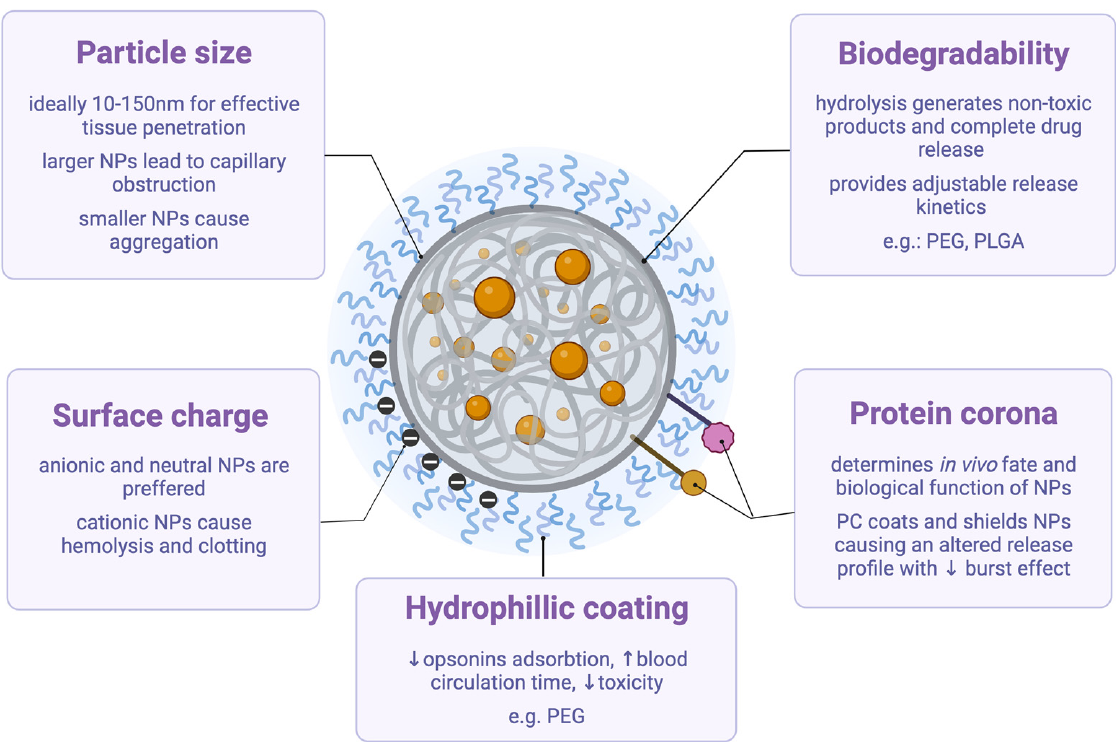
Figure 4. Factors affecting biocompatibility. This figure presents the main factors affecting the biocompatibility of nanoparticles (NPs), including their size, surface charge, hydrophilic coatings, potential biodegradability, and the formation of protein corona. PEG = poly (ethylene glycol), PLGA = poly-lactic glycolic-acid, PC = protein corona. Table 2. Summarized characteristics of MIPs that have reached in vivo studies.